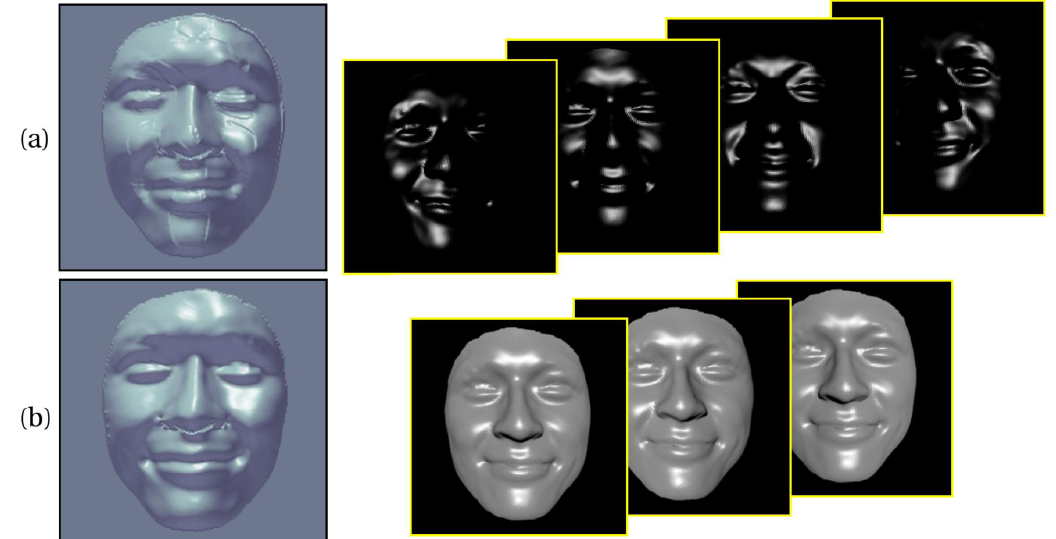
Fig. 12 First row: four purely specular input images as applied the purely specular model of Ref. [37] and the 3D reconstruction by that approach, which shows artefacts especially around the highly specular areas. Second row: three ordinary input images including both diffuse and specular components used as input to our method and our 3D reconstruction. Our method does not need to decompose the input images into purely diffuse and purely specular components, a very difficult task even for synthetic